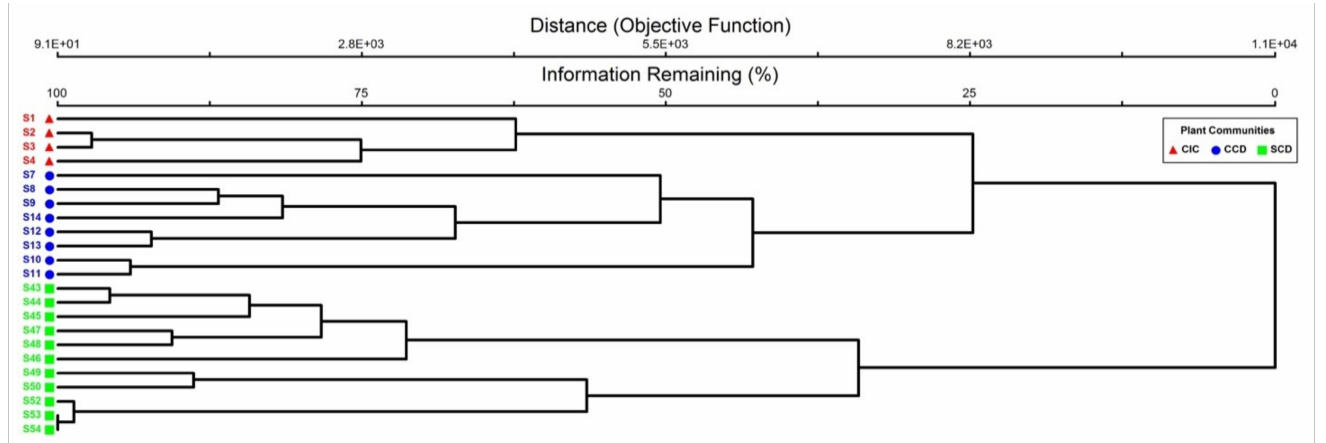
Figure 2. Cluster analysis displaying three different plant communities’ recognition based upon the grouping of 23 stands and 162 plant species. CIC, Cedrus–Isodon–Cynodon ; CCD, Cedrus–Cynodon– Dryopteris ; SCD, Sambucus–Cedrus–Desmodium .